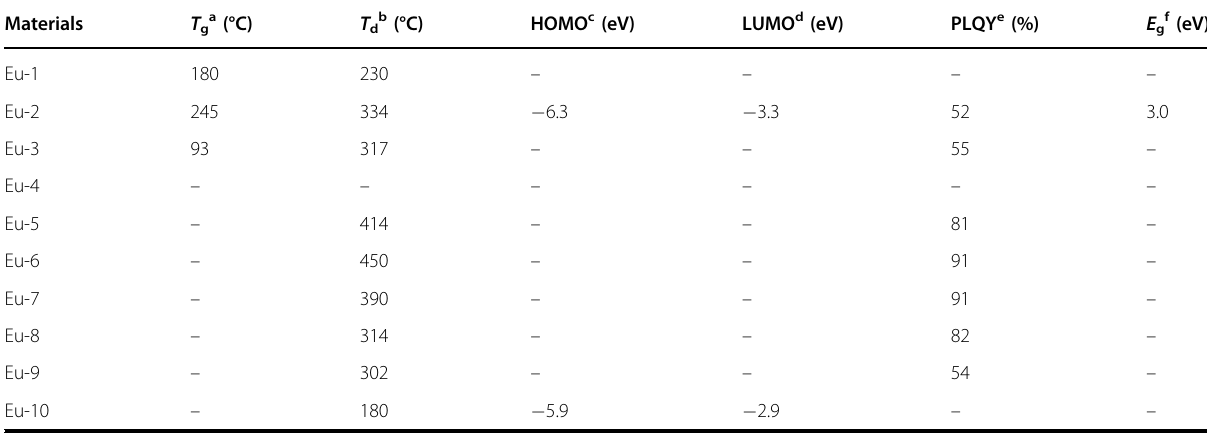
Table 2 The physicochemical properties of the representative europium complexes